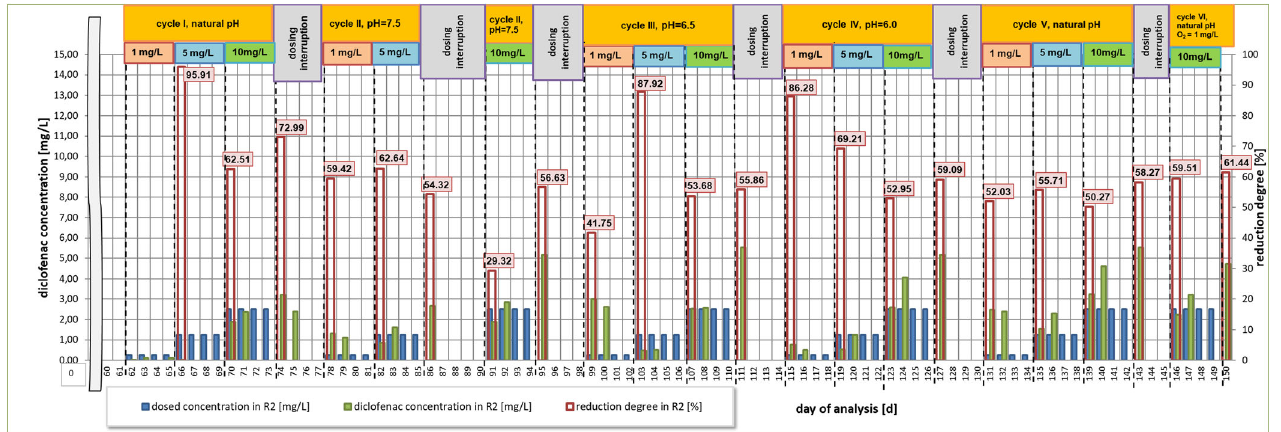
Figure 3. Degree of diclofenac reduction after 4 days from dosing a specific dose of the drug in the R2 bioreactor in all analyzed research series .